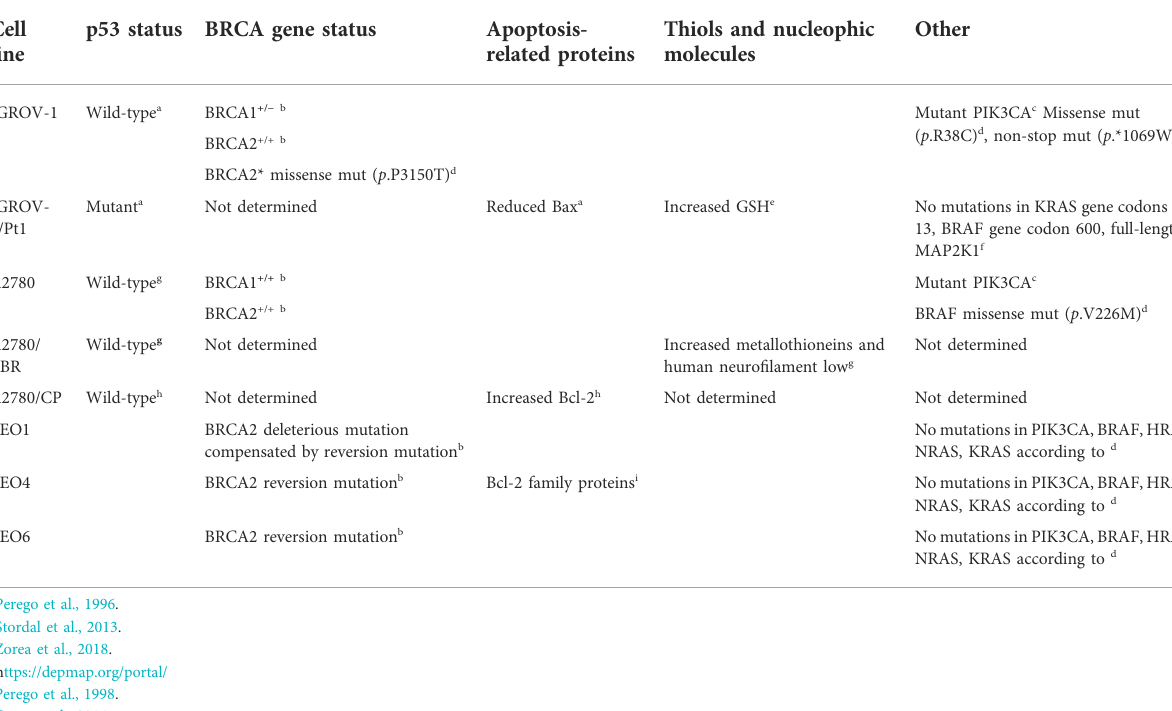
TABLE 2 Characteristics of the cell lines and drug-resistant